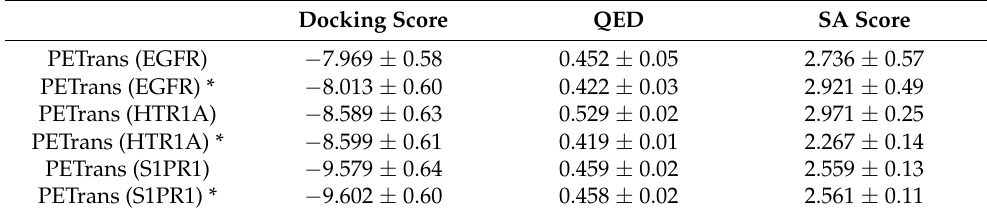
Table 2. Experimental results with and without the DSSP.